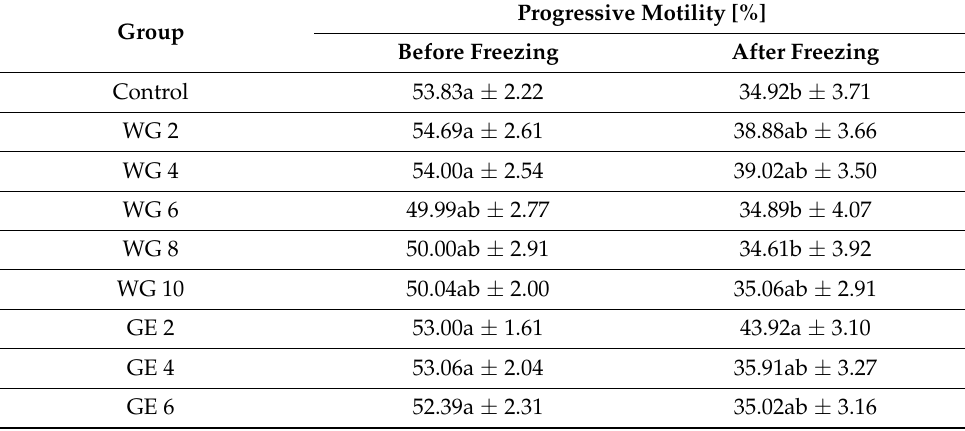
Table 2. Effect of various types of sea cucumber extract on progressive motility of spermatozoa before and after cryopreservation. Explanations: a–d—means with different superscript letters in the same column differ significantly at p <